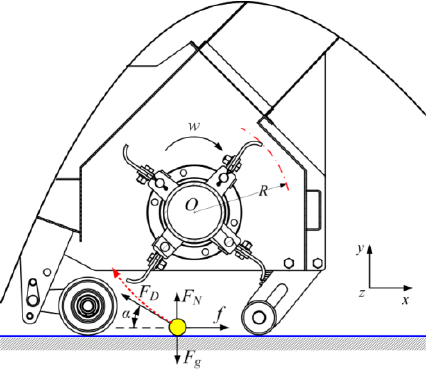
Figure 4. Kinematic analysis of impurity particles on the film surface.